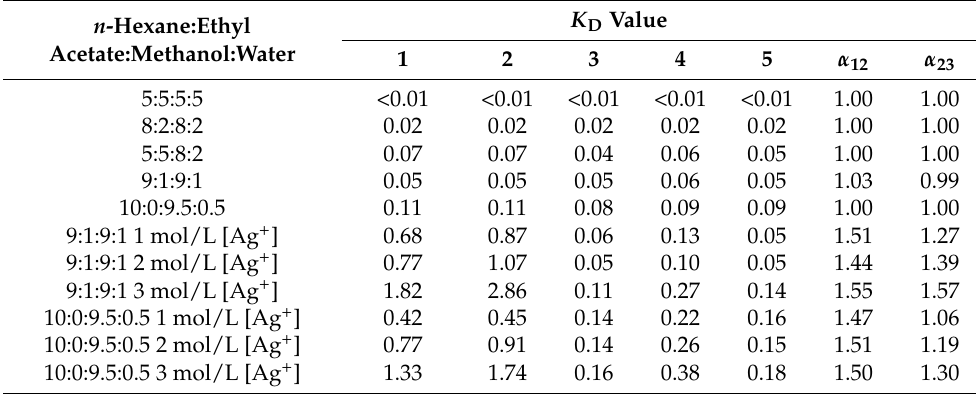
Figure 1. The chemical structures of compounds 1 – 5. Table 1. The partition coefficient ( K D values) of target compounds in different solvent systems.